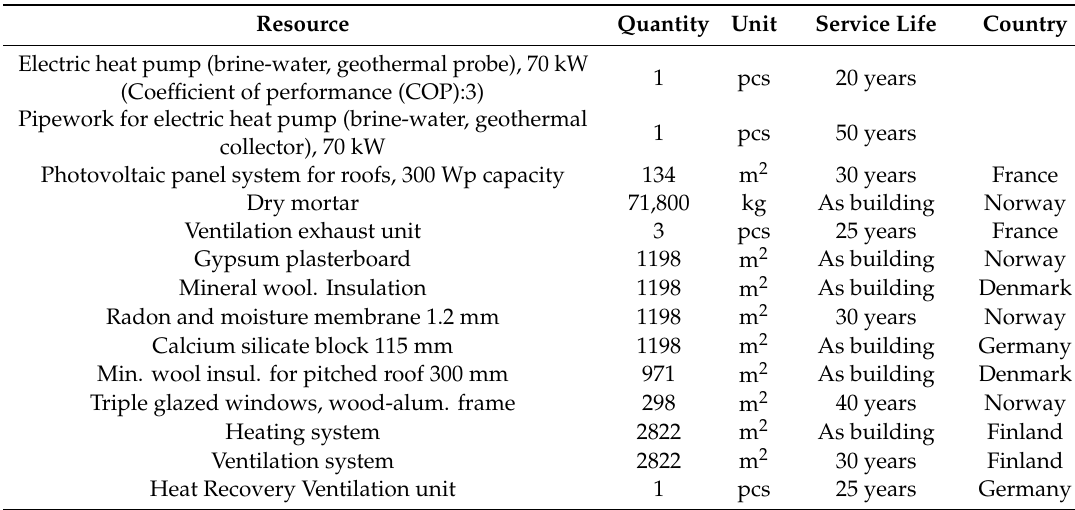
Table 2. Material datasets.